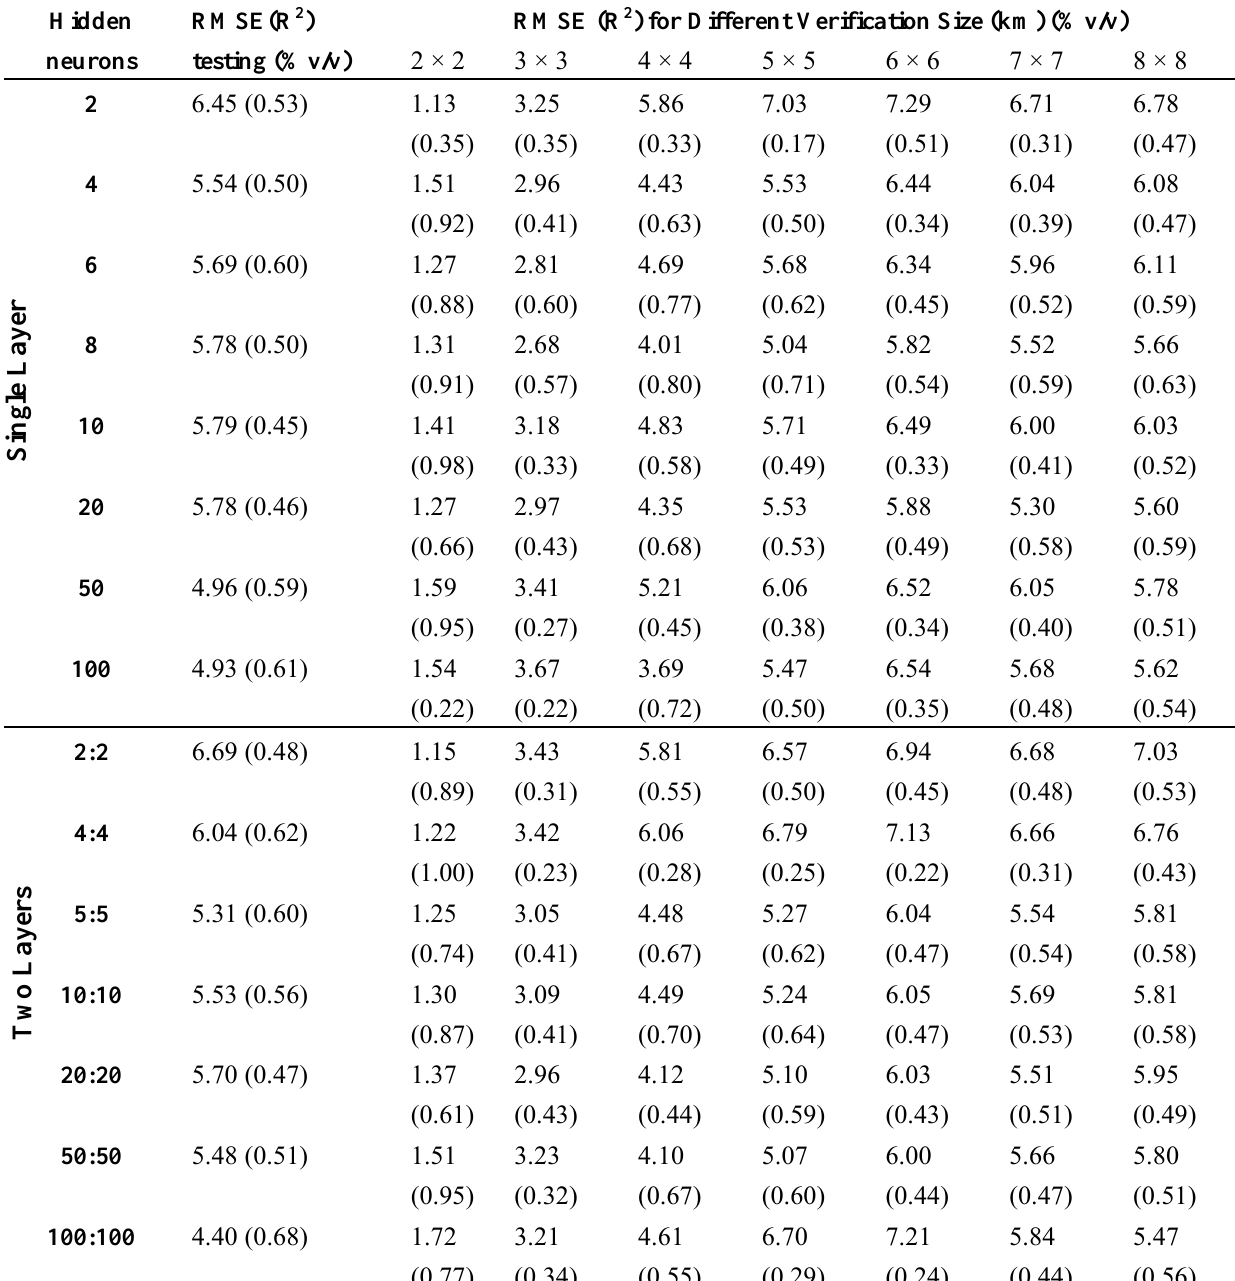
Table 6. As for Table 3 but using TbH, TbV, NDVI and LST as input.